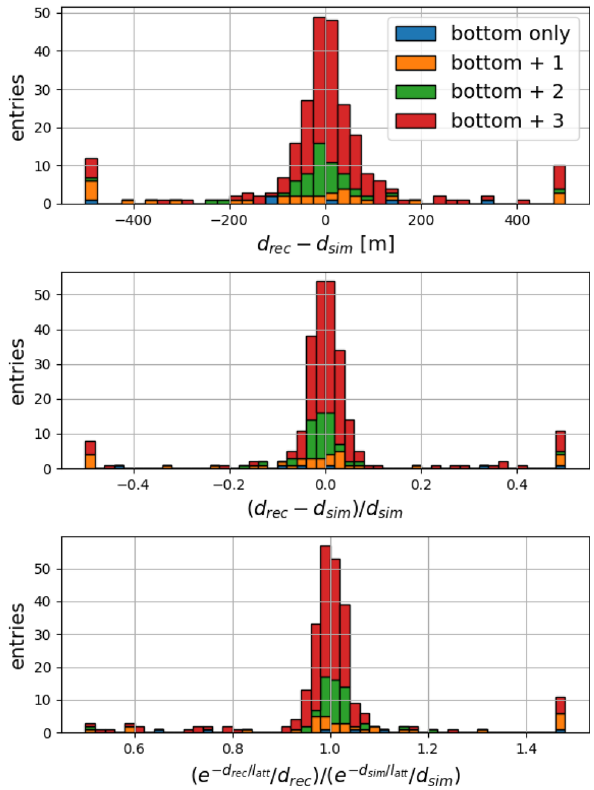
Fig. 11 Stacked histograms showing the performance of the vertex reconstruction for events where at least one channel detected two radio signals (DnR) with SNR > 2 . 5. Top: Difference between reconstructed and actual distance from station to shower. Middle: Relative uncer- tainty on the distance reconstruction. Bottom: Ratio of reconstructed and actual attenuation of the radio signal on its way from shower to detector. Events are divided into the same categories as in Fig. 8, but a much smaller subset of events (see Fig. 10) shows DnR